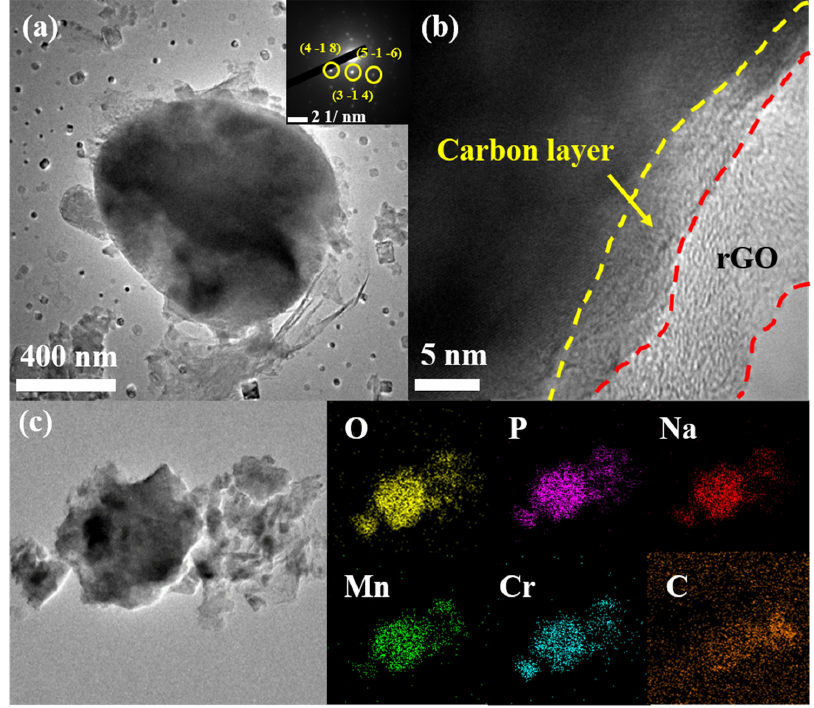
Figure 4. ( a , b ) TEM images of NMCP/rGO and SAED; ( c ) NMCP/rGO elemental mappings of oxygen (yellow), phosphorus (purple), sodium (red), manganese (green), chromium (blue) and carbon (orange).